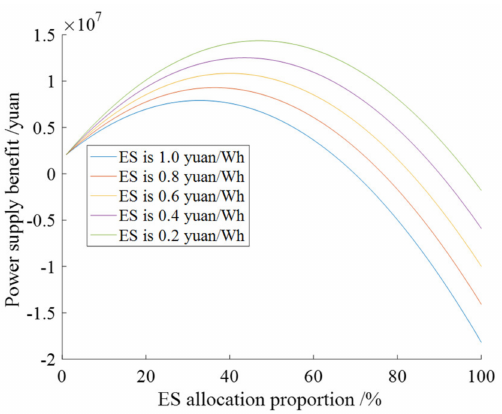
Figure 8. Power supply benefit curve under different ES investment costs.